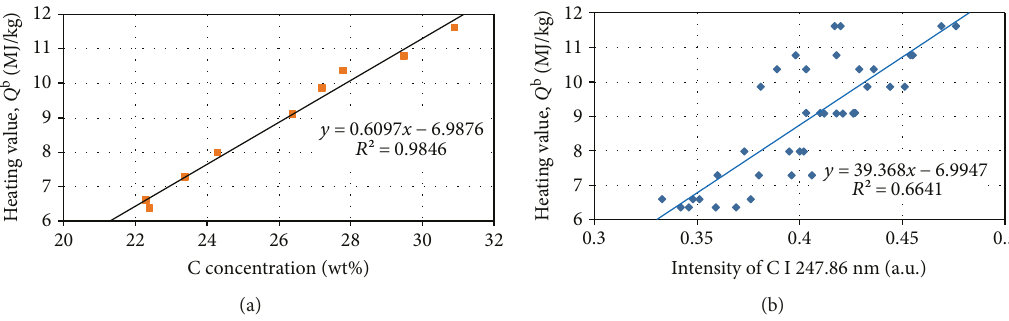
Figure 3: (a) Heating value of oil shale versus concentration of total C, data from Table 1. (b) Heating value as a function of the normalised intensity of C I line at